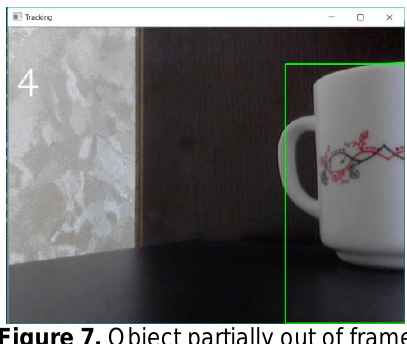
Figure 7. Object partially out of